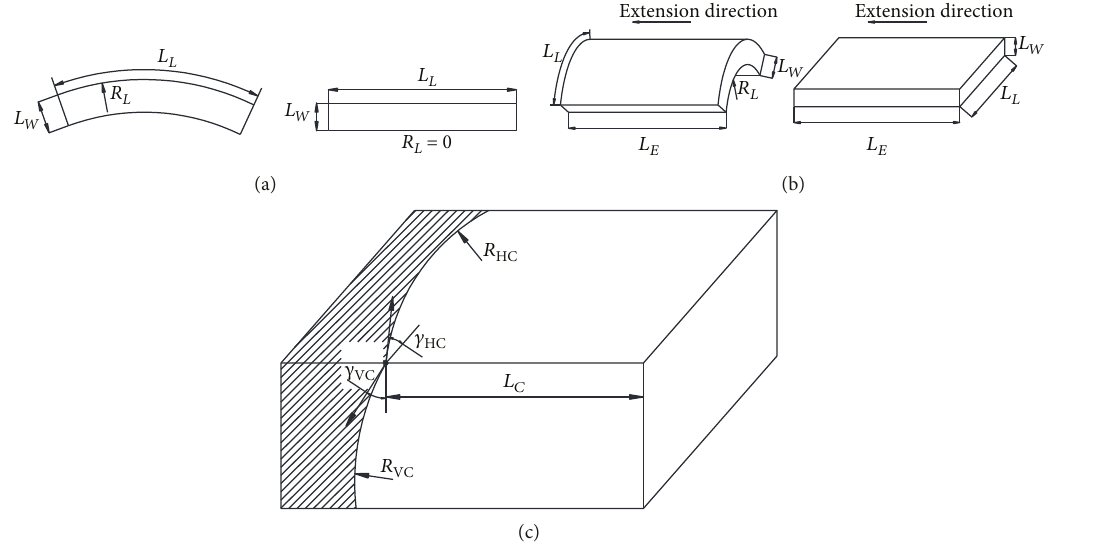
Figure 12: De fi nitions of the basic structure